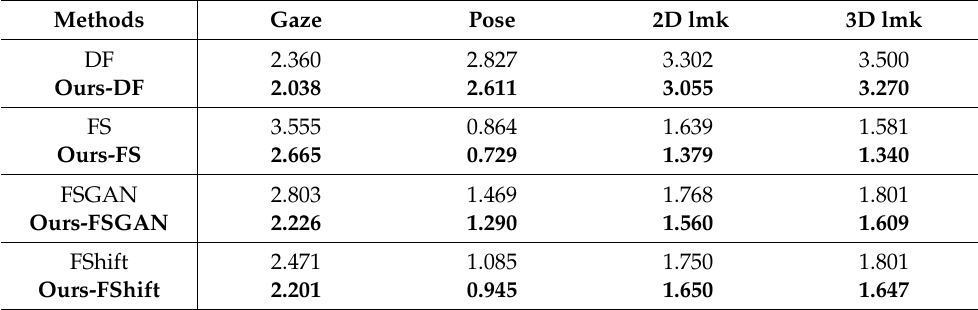
Table 2. Quantitative comparisons among different face-swapping methods of gaze direction, pose, 2D landmarks, and 3D landmarks. Our method apparently reduces the attribute differences which represents that our method can better inherit the attributes from the target video.